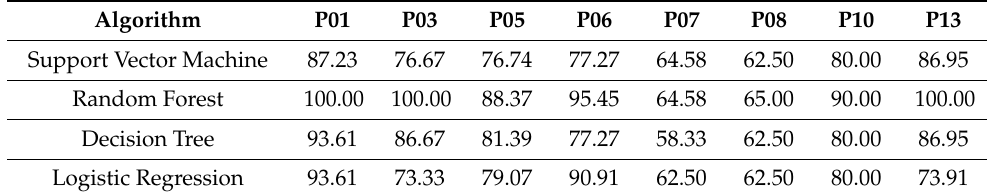
Table 10. Accuracy (%) of the classification of mood states based on 3 smartwatch variables and 2 daily form variables